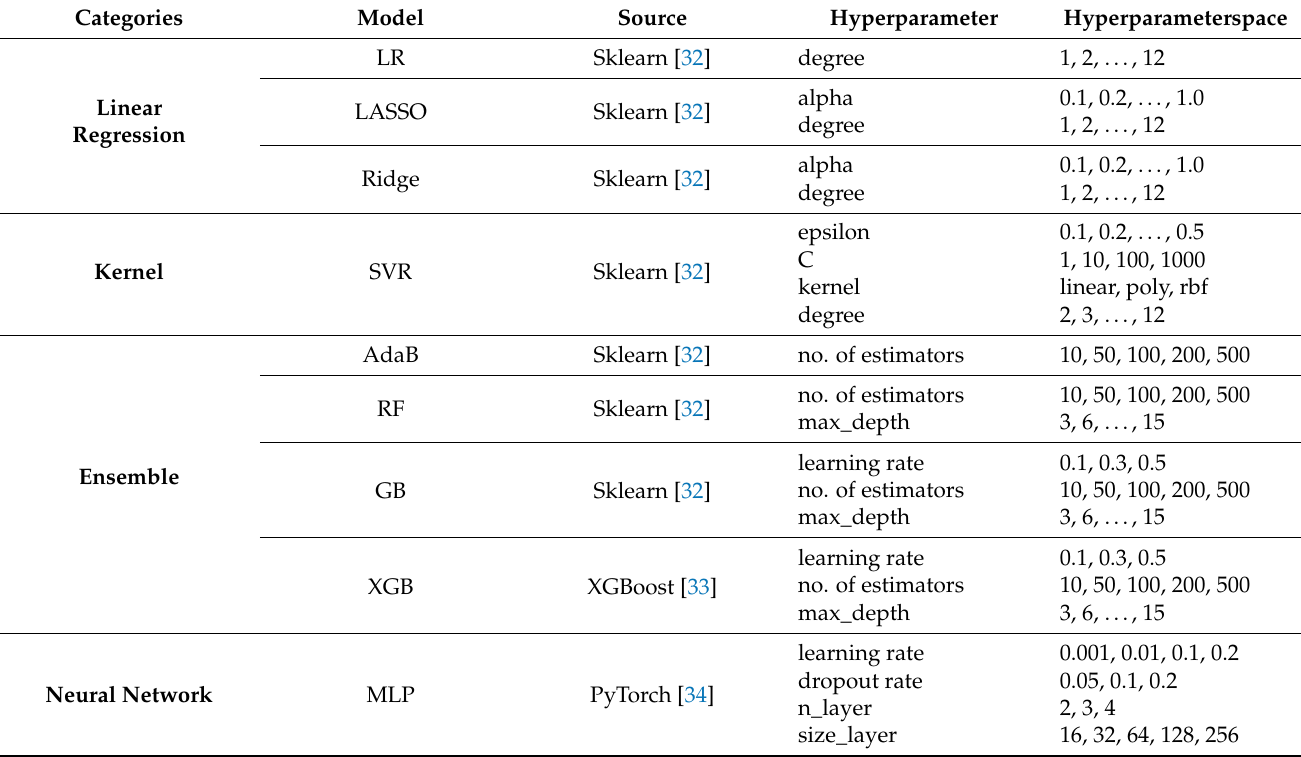
Table 2. Hyperparameters of ML methods being used in this present